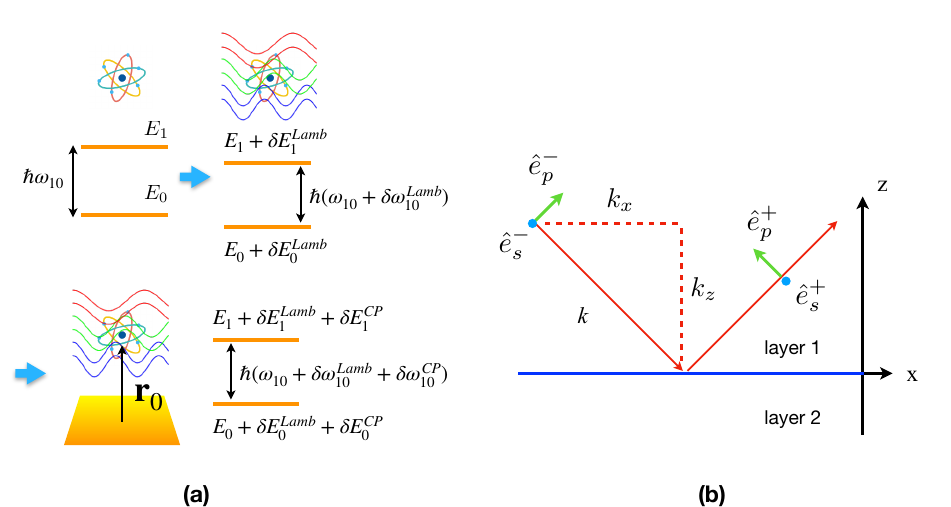
Figure 2. ( a ) Schematic depiction of an atom (modeled by a two-level system with ground state energy E 0 and excited state energy E 1 ) in vacuum, interacting with an axionic topological insulator (represented by the gold surface). The interaction is via dipole radiation coupling; in vacuum, this gives rise to the Lamb shift δ E Lamb a . As an atom in state induces an additional shift δ E CP a ; this is the Casimir–Polder energy for the atomic state p polarizations denoted, respectively, by e ± s (blue dot, directed along the negative y-direction) and e ± p (green arrow), for the case where the plane of incidence is the xz plane. For this case, the transverse wave vector lies entirely along the x direction, k y = 0, and e ± s = ( 0, The + ( ) superscript refers to a wave propagating in the positive (negative) z-direction, k = ω / c , − and red arrows denote the propagation directions of incident and reflected